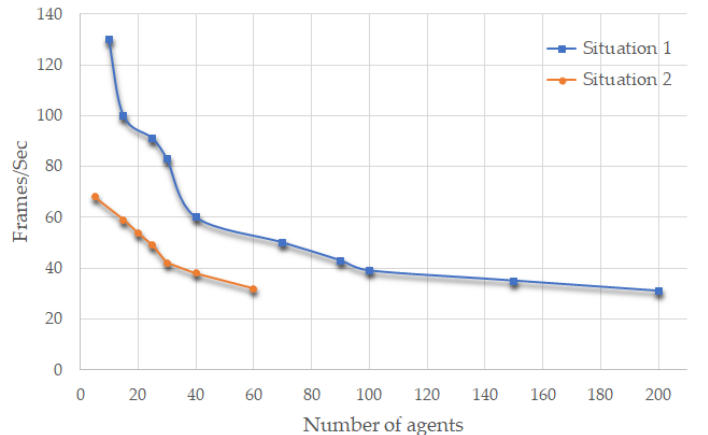
Figure 10. Frame rates for the different number of agents in a group based on two main situations. Situation 1 is the confrontation of two groups or one group with individual agents (without any obstacle). Situation 2 is the group in a challenging area (with